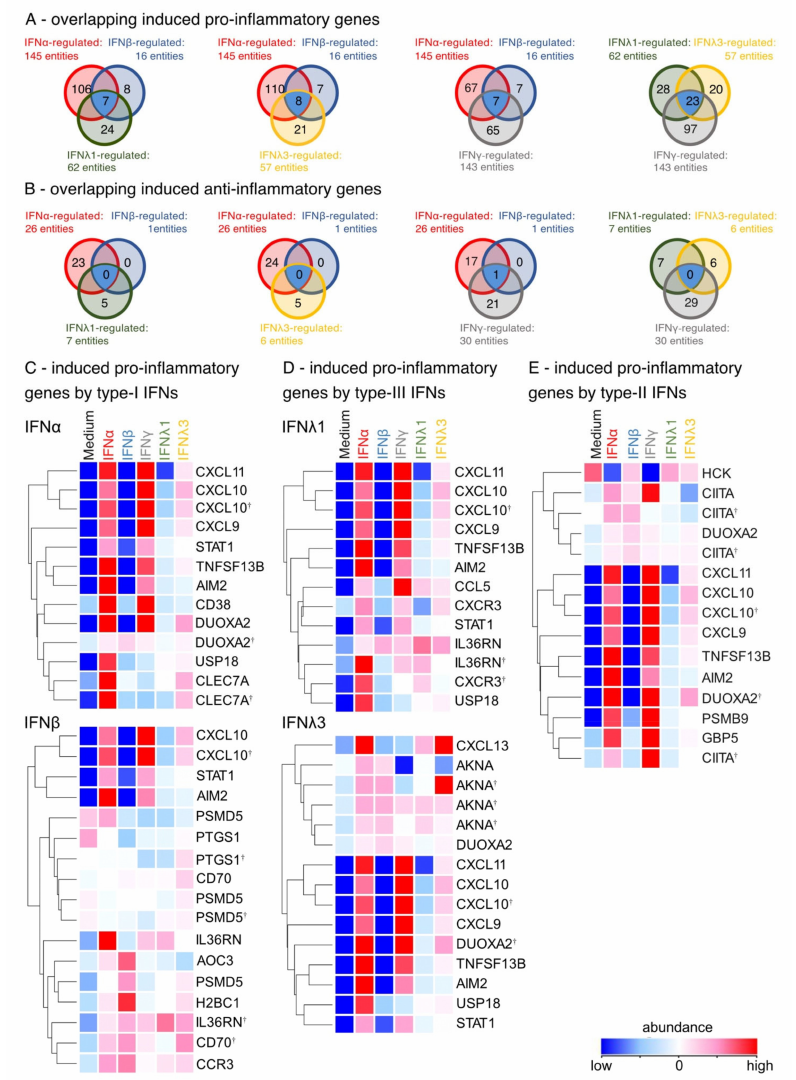
Figure 4. IFN stimulation leads to differentially expressed pro- and anti-inflammatory genes. ( A ) Venn blot of overlapping regulated pro-inflammatory genes by type-I, -II and -III IFNs. Test IFN α -stimulated vs. ttest IFN β -stimulated and ttest IFN λ 1-stimulated.Ttest IFN α -stimulated